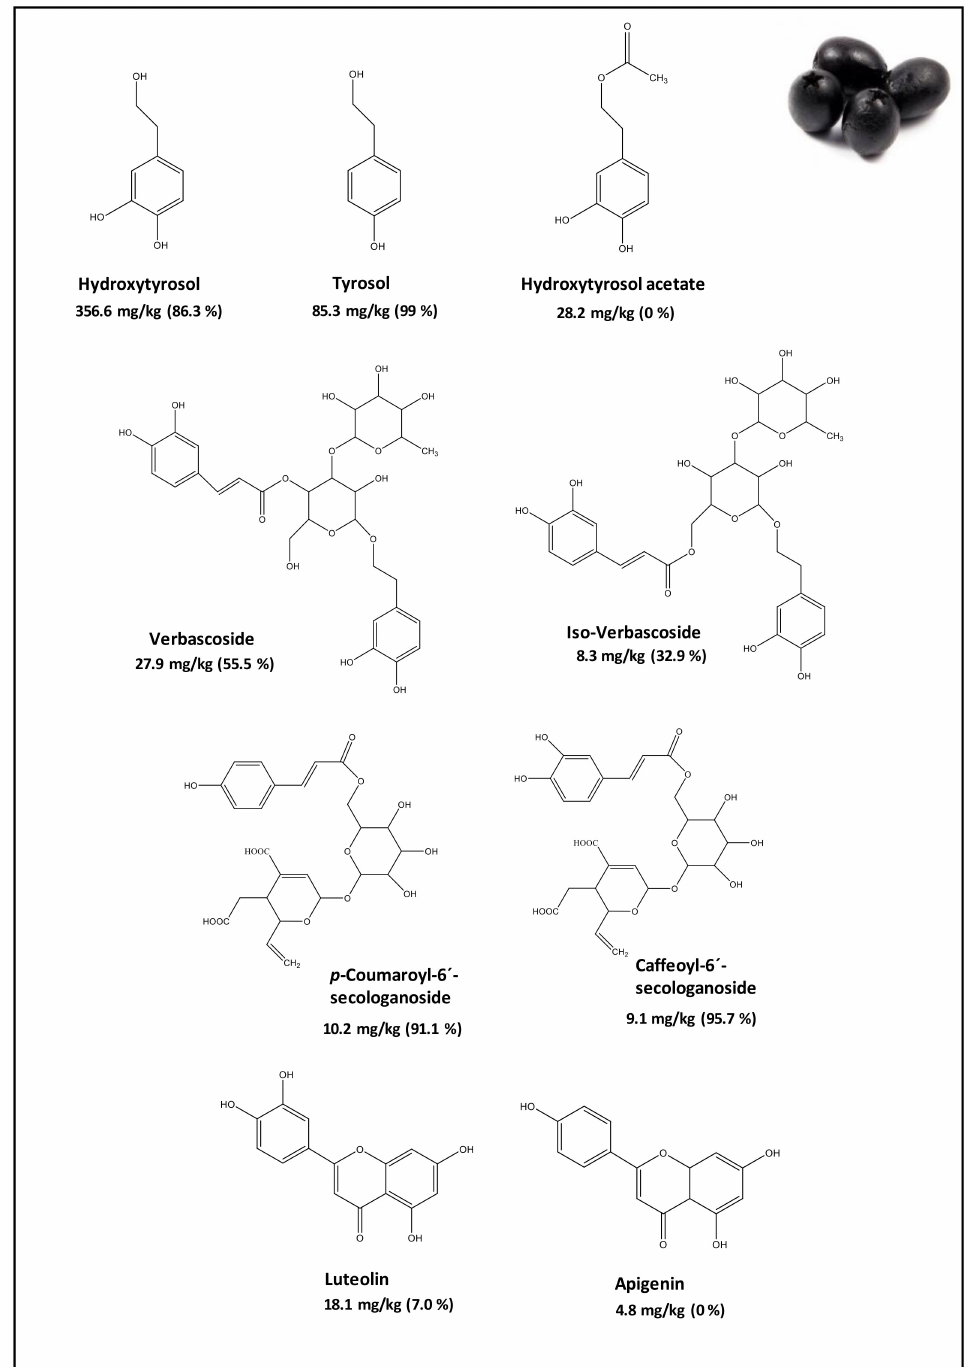
Figure 3. Phenolic compounds determined in olives (mg/kg) and their potential bioaccessibility after in-vitro digestion (%). Data taken from D’Antuono et al.